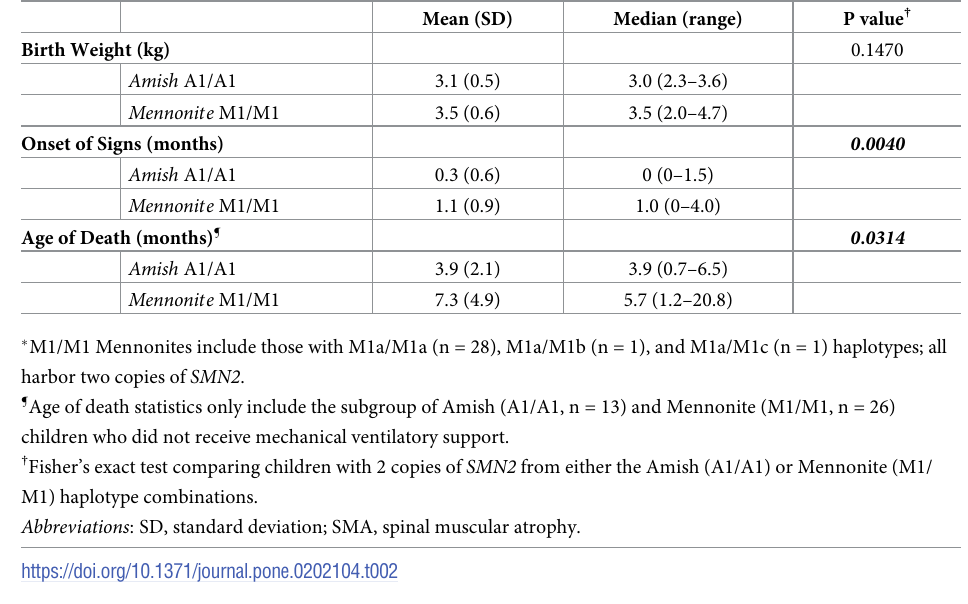
Table 2. A1/A1 (n = 14) and M1/M1 (n = 30) (cid:3) infants with 2 copies of SMN2